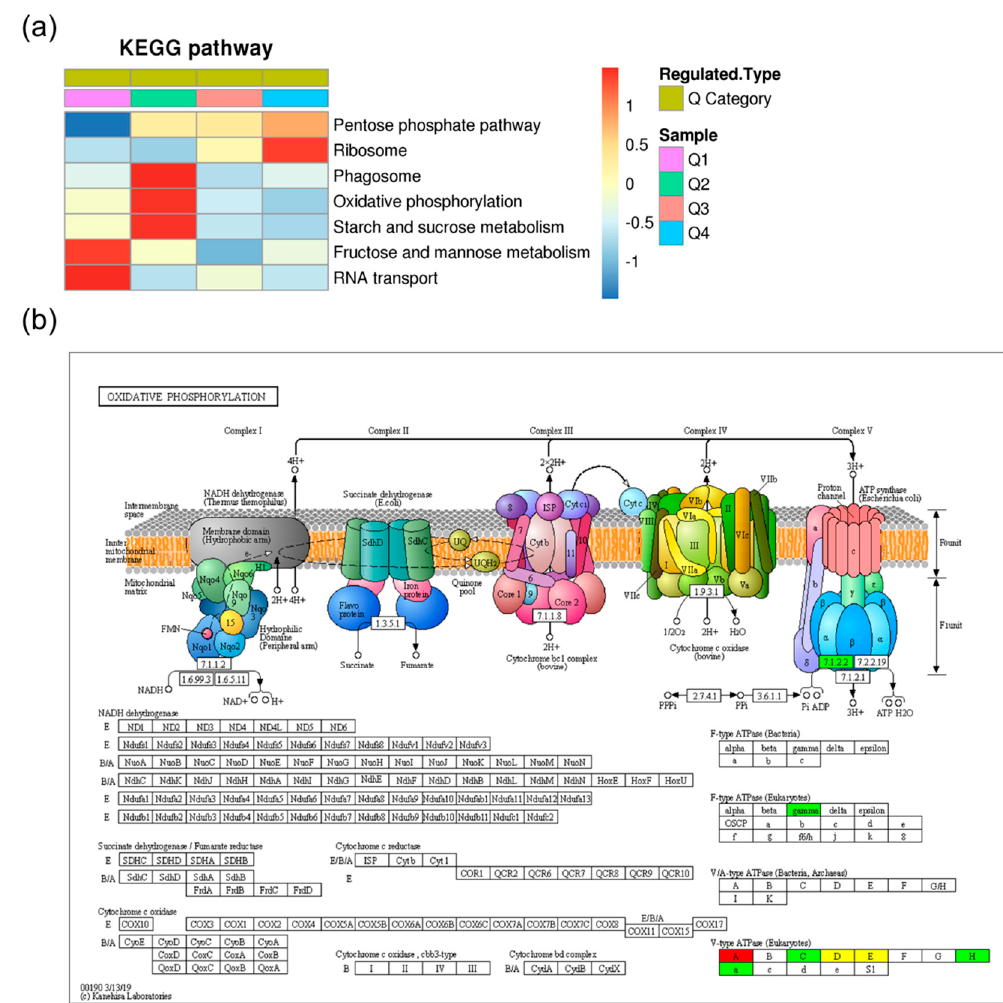
Figure 4. KEGG pathway analysis of the differentially expressed lysine ubiquitinated proteins. ( a ) KEGG pathway-based clustering analysis of the differentially expressed ubiquitinated proteins. Those pathways at least enriched in one of the clusters with p value <0.05 were clustered. The p value matrix was transformed by the function x = − log10 ( p value), and were then z-transformed for each category. These z scores were clustered by one-way hierarchical clustering and visualized by a heat map using R-package; ( b ) the pathway obtained from KEGG pathway enrichment analysis. The colors reflect ubiquitinated level upregulated (red), downregulated (green), or both upregulated and downregulated at different modification sites (yellow).